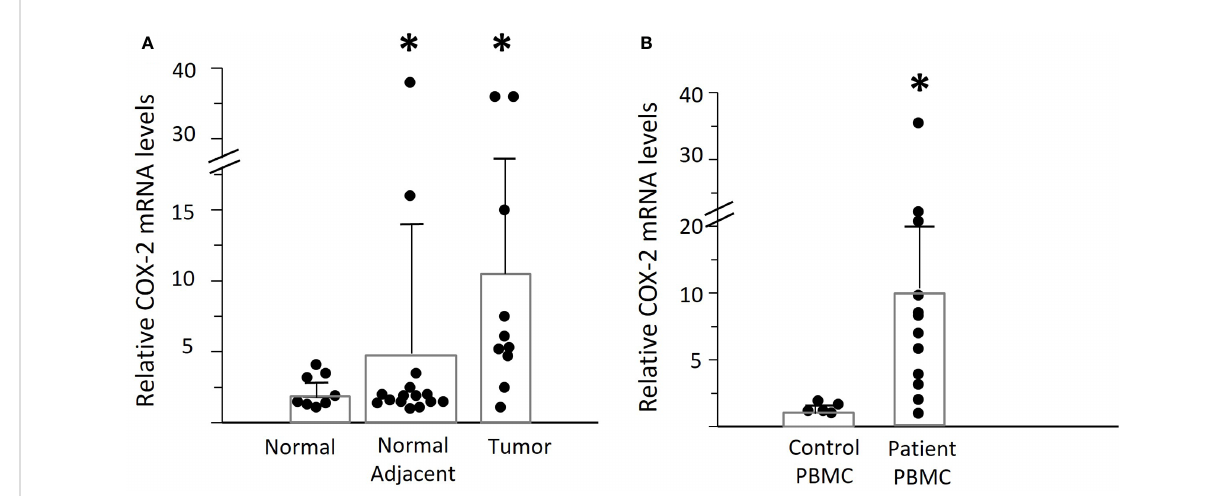
FIGURE 3 Expression of COX-2 mRNA in OPC tissues and PBMC. (A) Levels of COX-2 mRNA were assessed by q-RT-PCR in biopsies of OPC tissues (n=10) and clinically normal contralateral tissue (normal adjacent) from patients with OPC (n=15), relative to normal tonsil tissues (n=8.) Bars indicate mean +/- SD. There was a signi fi cant increase in expression in the tumor tissues of patients (*p=0.048, unpaired t test with Welch ’ s correction). (B) COX-2 mRNA levels were measured in PBMC from patients with OPC (n=12) and expressed relative to the lowest measurable level in PBMC from controls (n=5). There was a statistically signi fi cant increase in the patients ’ PBMC as compared to controls (*p<0.01, Mann- Whitney